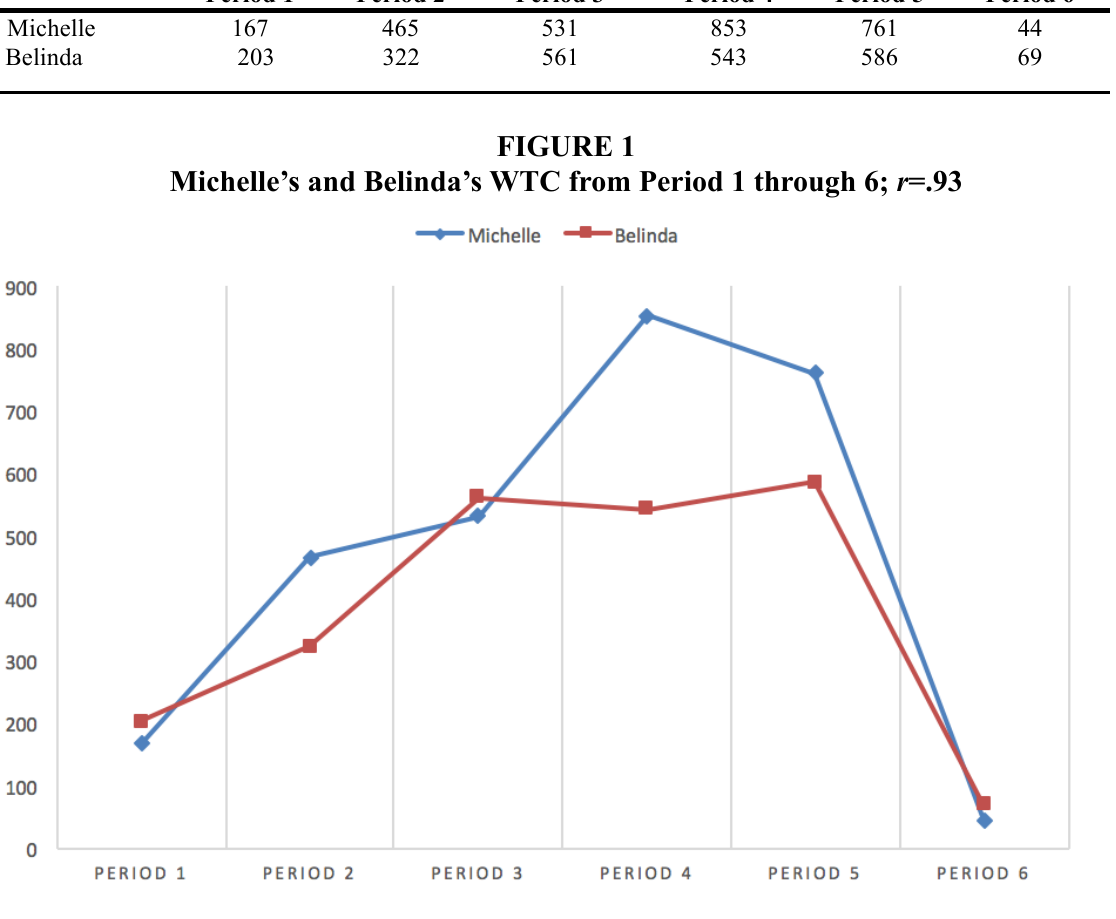
Michelle ’ s and Belinda ’ s WTC from Period 1 through 6 Period 1 Period 2 Period 3 Period 4 Period 5 Period 6